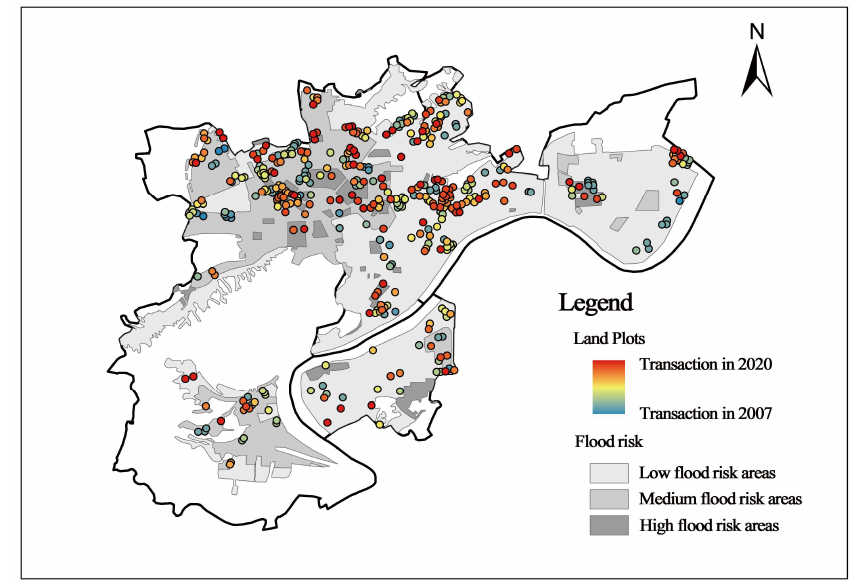
Figure 2. The locations of the residential land transaction samples.